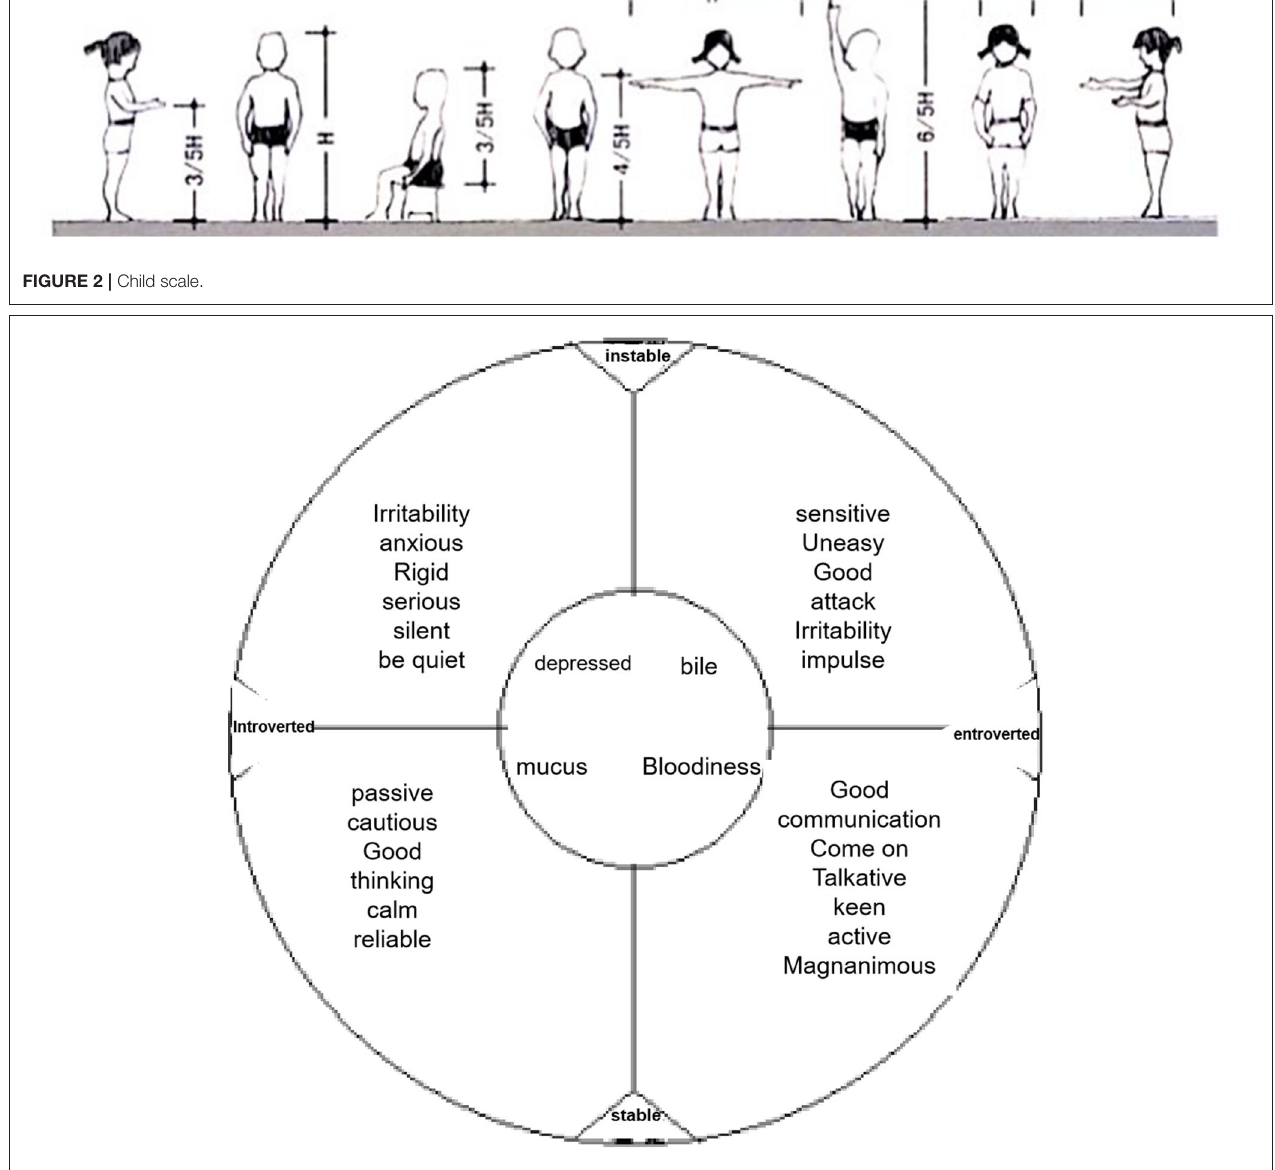
FIGURE 3 | Eysenck personality questionnaire subscale. Source: medical